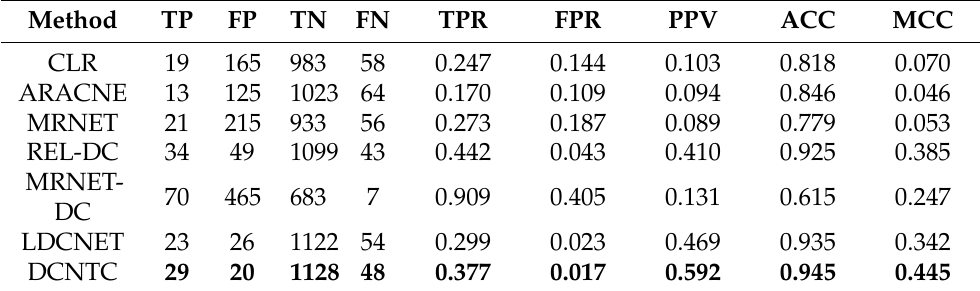
Table 2. Comparison of the performance of different methods for inferring a 50-gene network in DREAM3.